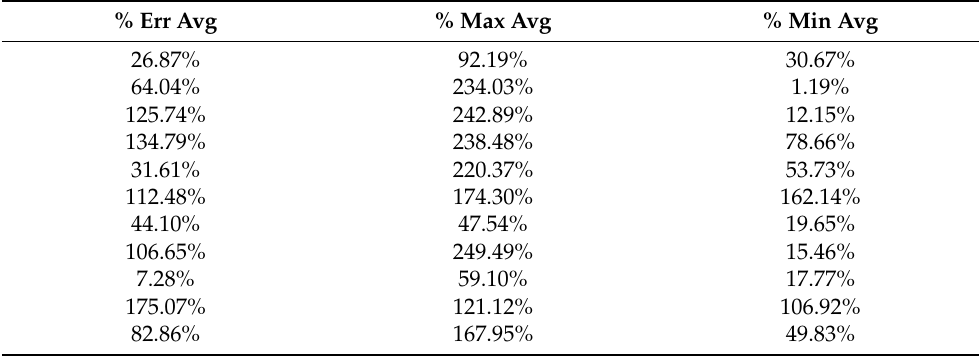
Table A103. Set 2, trials 11–20 data (single 0.5 PR value).